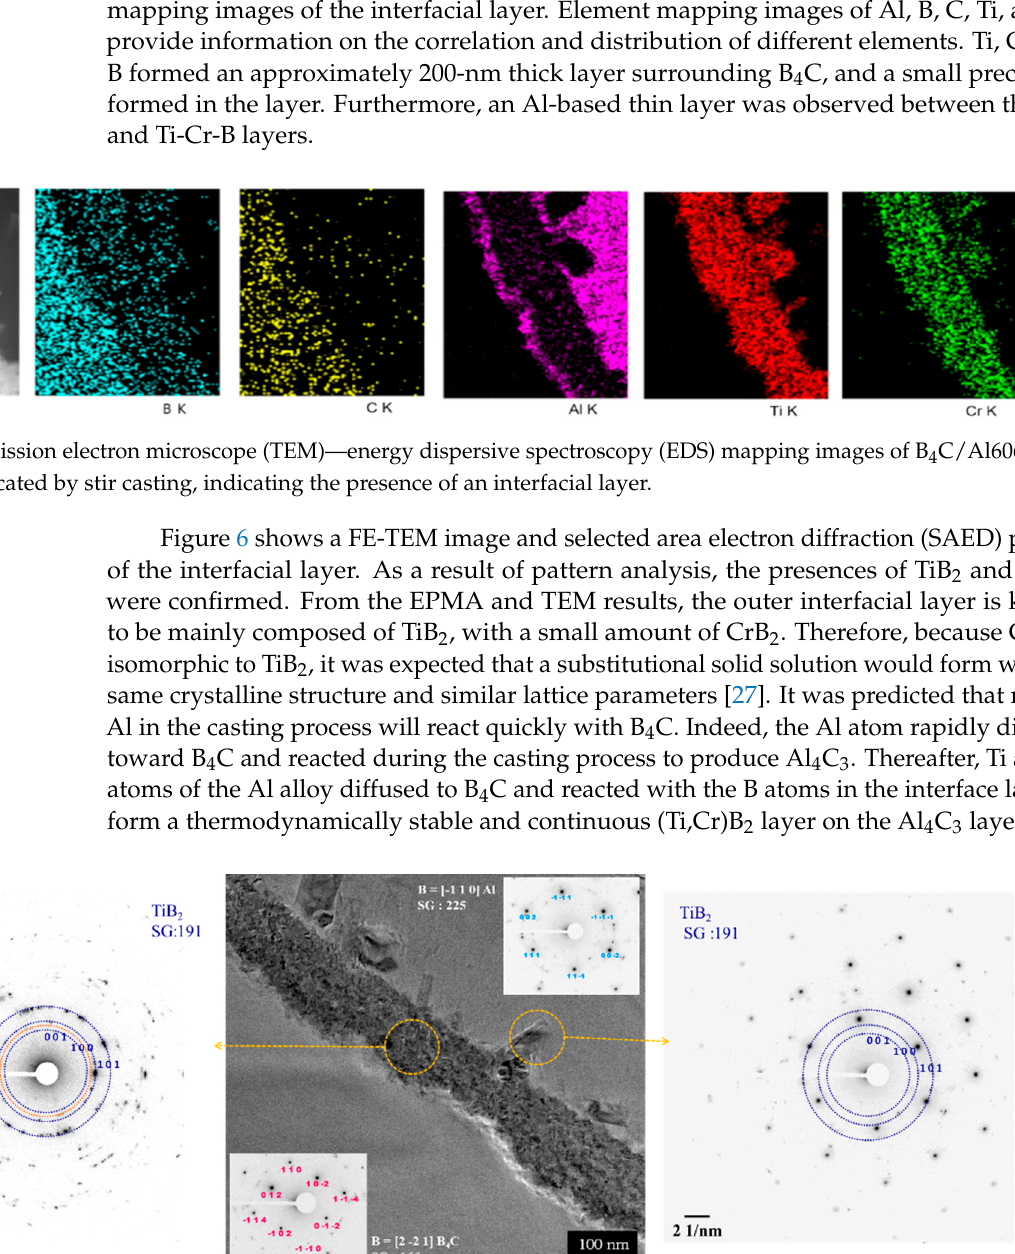
Figure 4. EPMA analysis of ( a ) B 4 C/Al6061 stir-cast AMCs and ( b ) hot-rolled AMCs at 30 vol.% B 4 C.